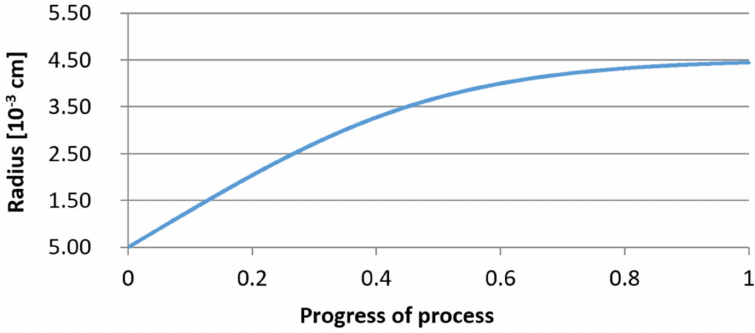
Figure 23. Growth of the radius of nucleus (with initial radius r 0 = 5 µ m) in steel